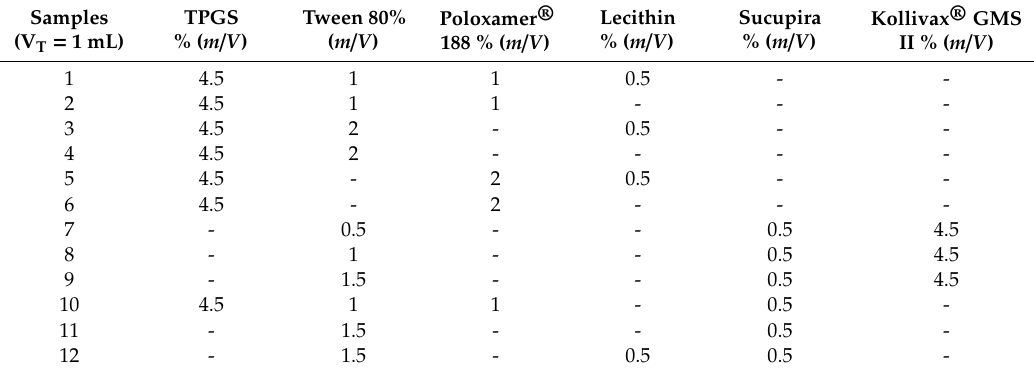
Table 1. Composition of surfactant screening formulations.